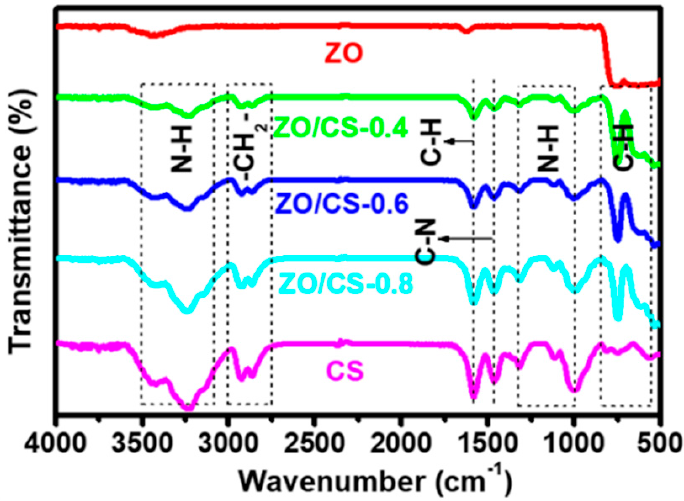
Figure 4. ( a ) UV-vis DRS of ZO, CS, and ZO/CS nanocomposites; ( b ) plots of ( α h ν ) 2 versus energy ( h ν ) for ZO and CS.